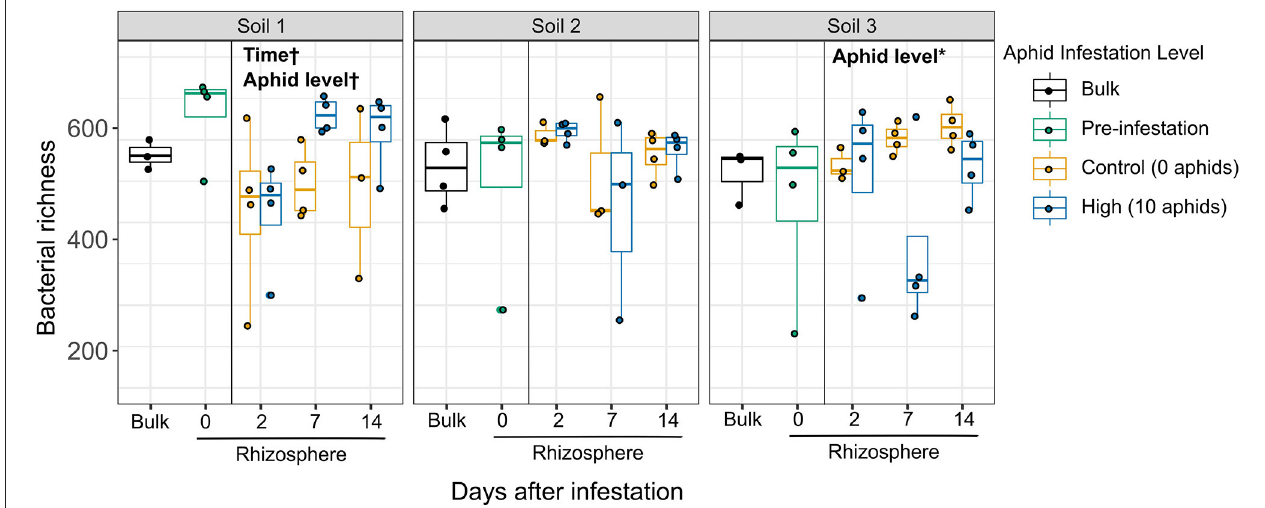
FIGURE 3 | Top-down effects of high levels of aphid herbivory on rhizosphere bacterial taxonomic diversity vary across soils. Boxplots showing average bacterial richness (number ASVs/sample) of individual samples, comparing high aphid-infestation and no aphid infestation in each soil type (soils analyzed separately). Statistically different factors (* p < 0.05, † p < 0.1) are labeled on the panel to which they